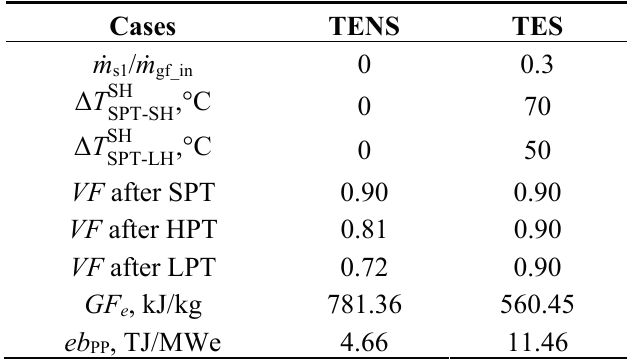
Table 3. Comparison of the air-cooled triple-expansion plants without (TENS) and with (TES) superheating for T gf_in = 400 °C and P gf_in = 23 MPa.